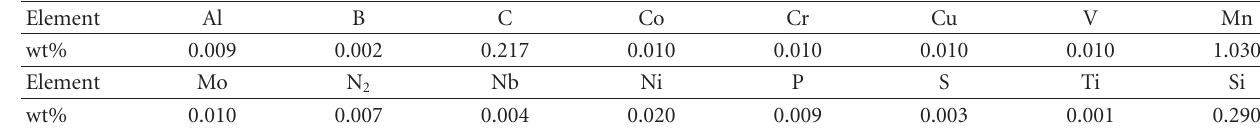
Table 1: The A516 pressure vessel steel composition.